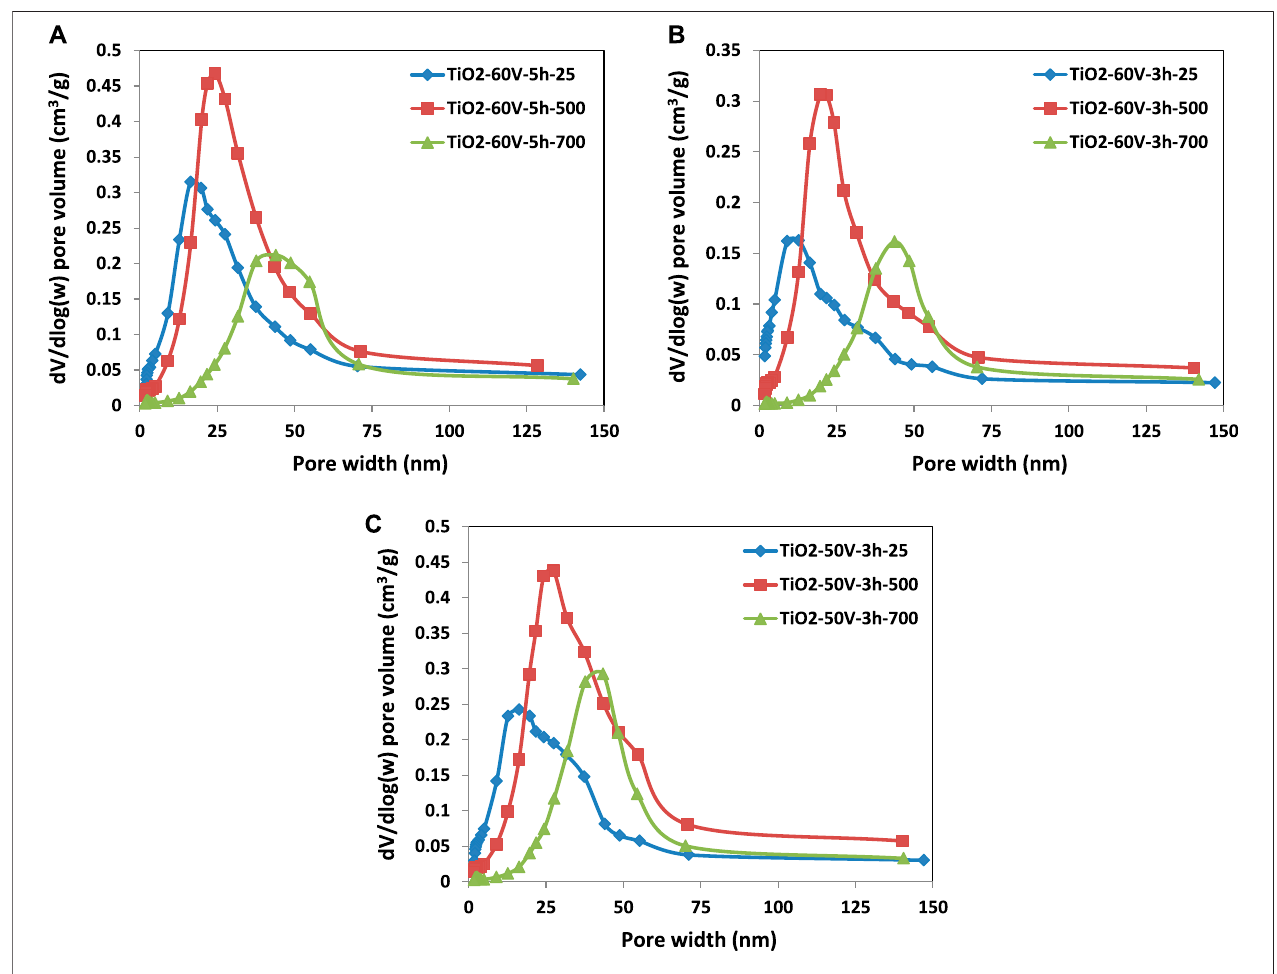
FIGURE 5 | Pore size distribution versus pore volume of the TiO 2 samples: (A) TiO 2 -60V-5h, (B) TiO 2 -60V-3h, and (C) TiO 2 -50V-3h.